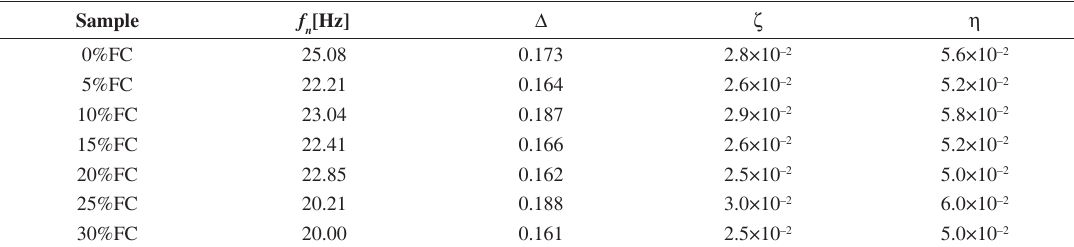
Table 4. Natural frequency ( f Samples